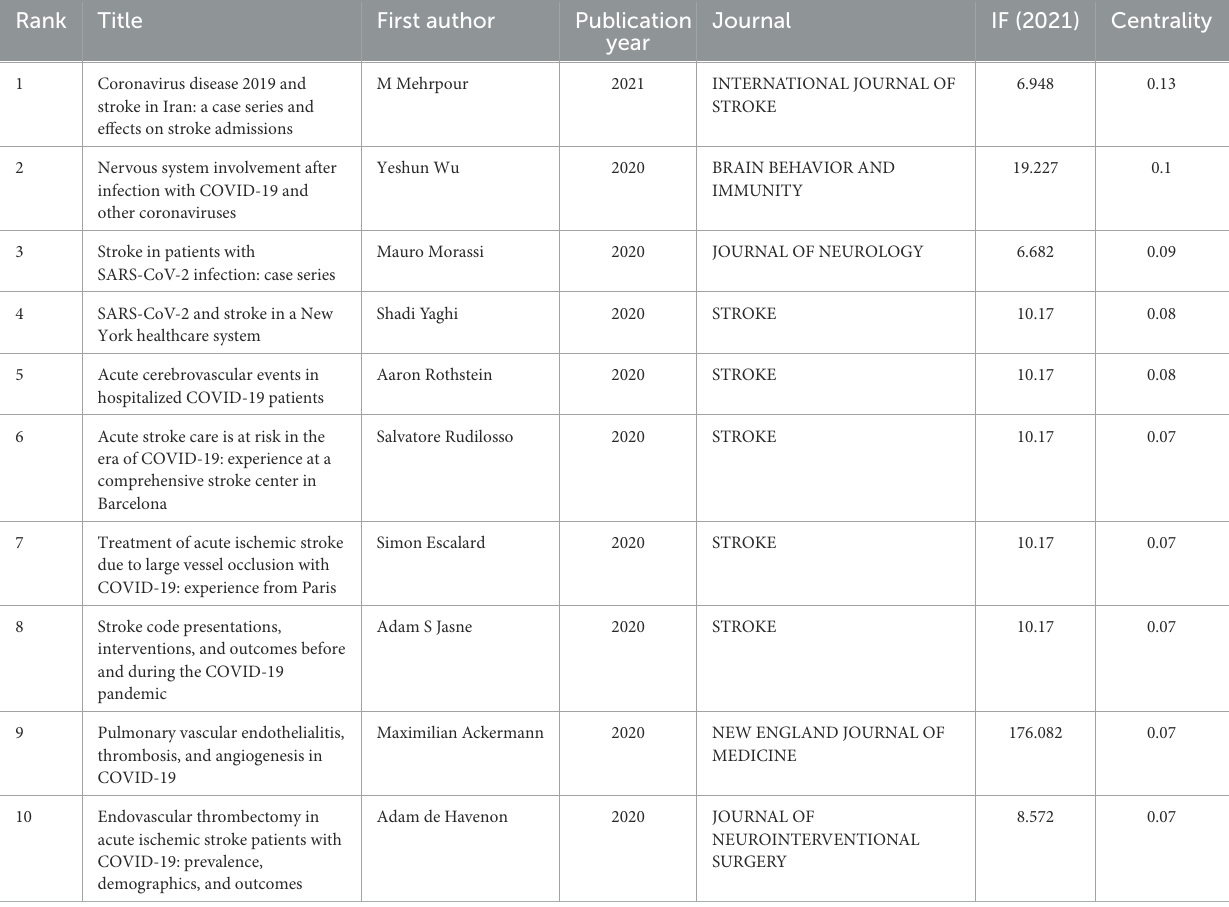
TABLE 8 Top 10 cited references in COVID-19 and stroke-related studies ranked by